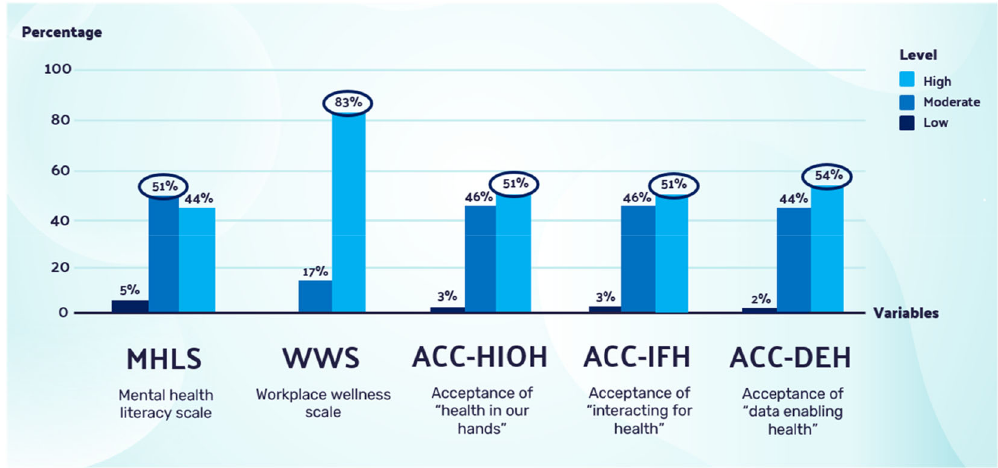
Figure 3. MHLS, WWS, ACC-HIOH, ACC-IFH and ACC-DEH among digital workers. MHLS, WWS, ACC-HIOH, ACC- IFH and ACC-DEH were normally distributed, with skewness between (cid:1) 0.54 to 0.08 and kurtosis between (cid:1) 0.46